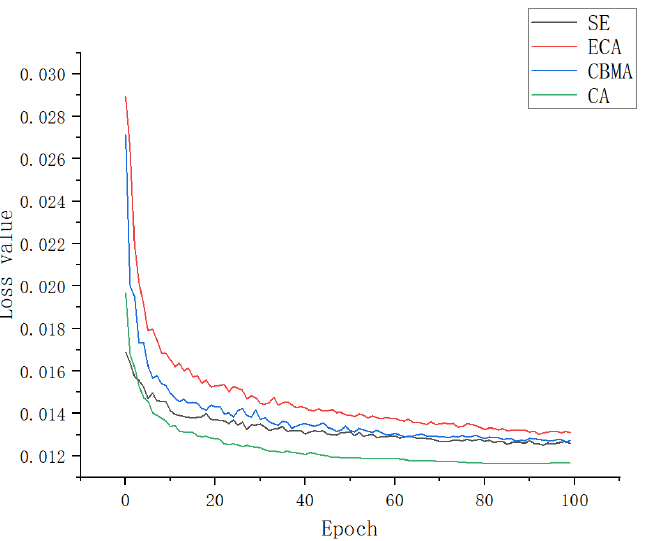
Figure 16. Loss value of each module.